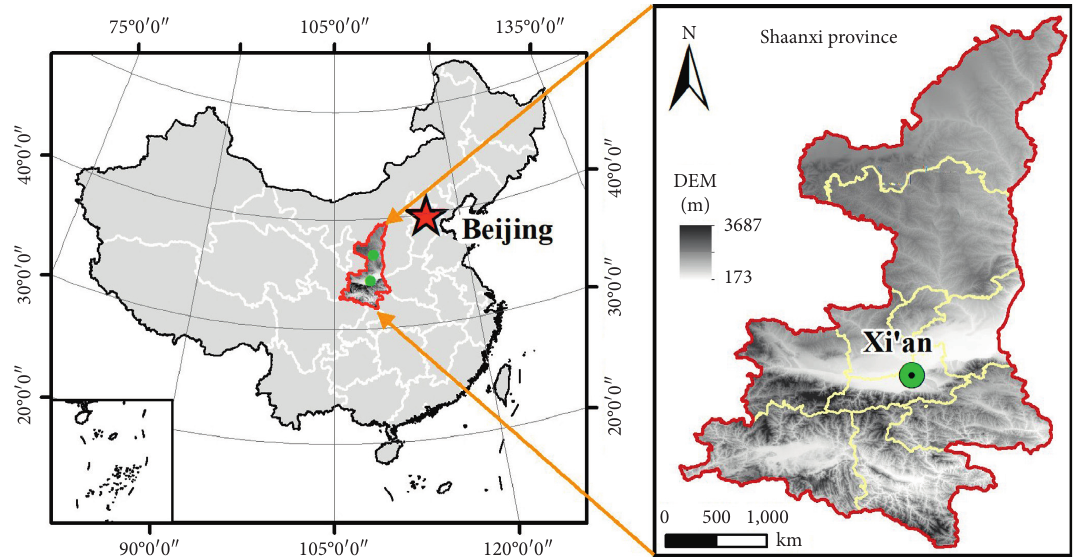
Figure 1: Study area of Xi’an, Shaanxi province,